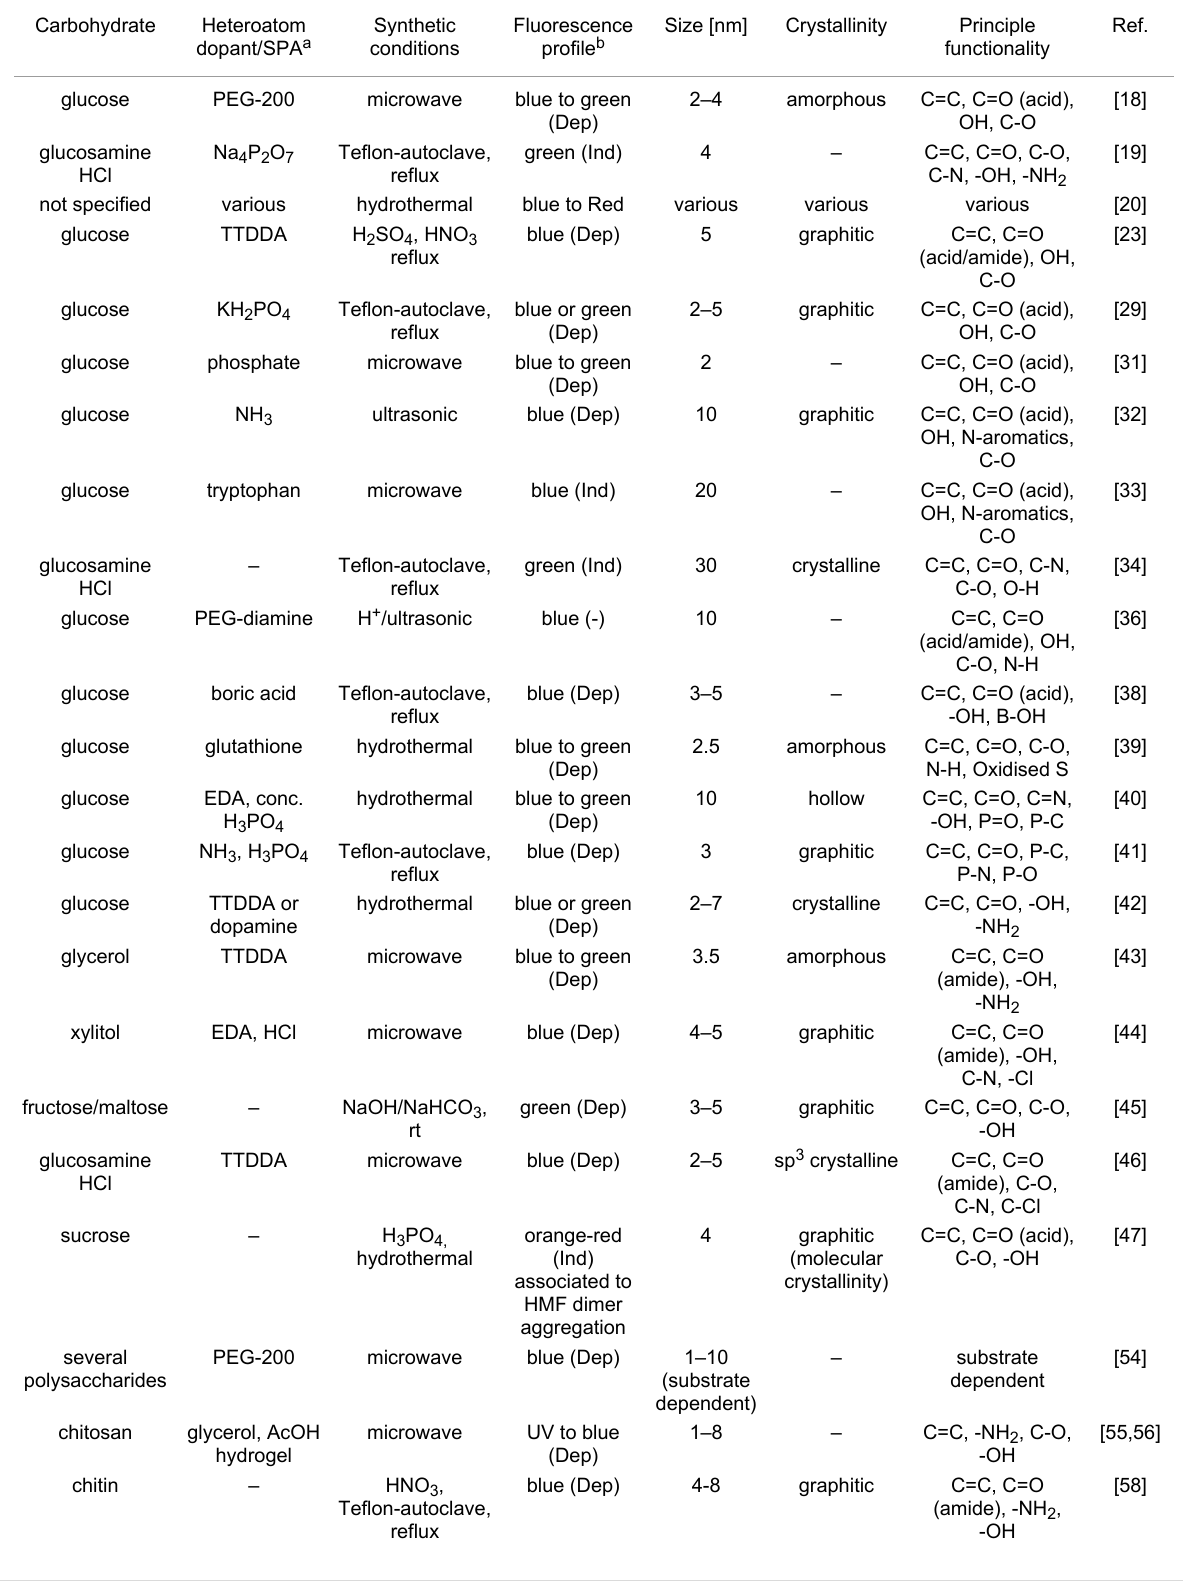
Table 1: Summary of carbohydrate-derived CDs synthetic protocols and properties.